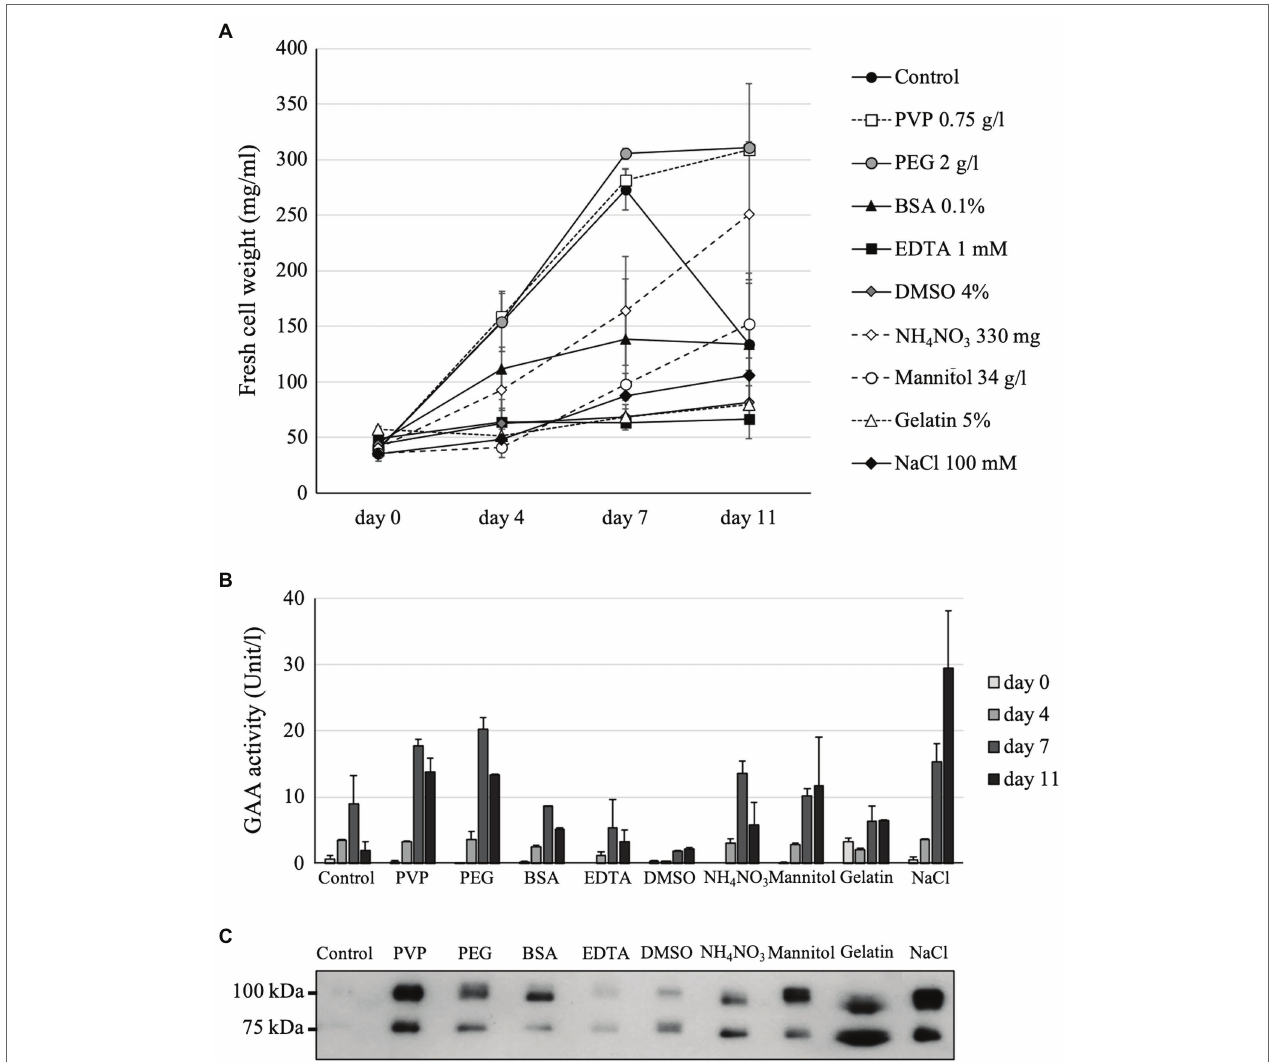
FIGURE 3 | Effects of chemical additives on the cell growth of GAA-producing Arabidopsis alg3 cell culture (A) as well as on GAA production as evaluated by a GAA activity assay (B) , and Western blotting (C) . Data of (A) are average of three independent replications. The media of 11-day-old cultures are used for the Western